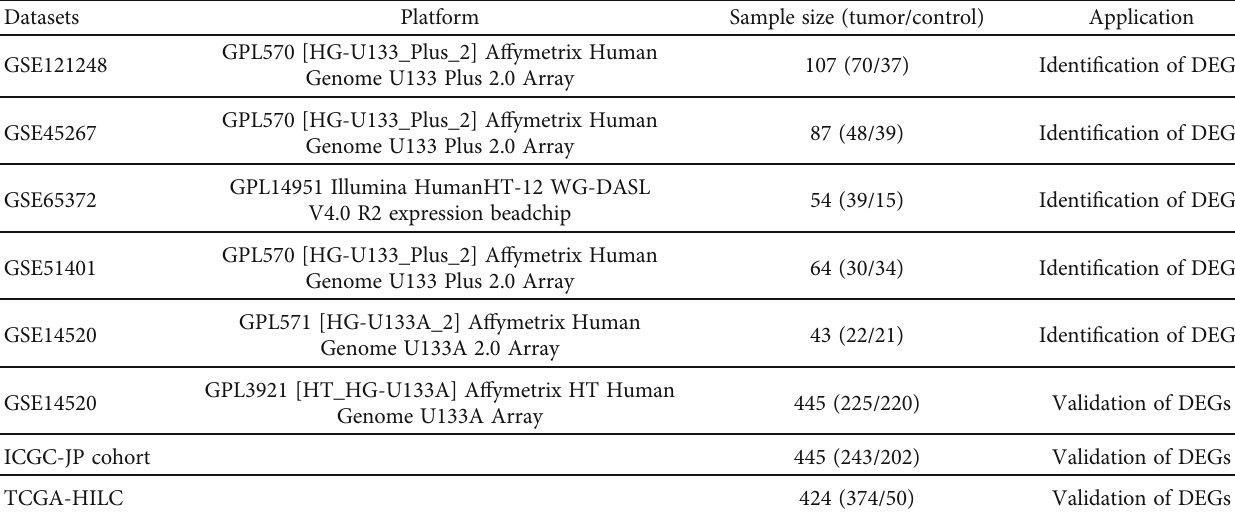
Table 1: Details of the multiple datasets included in this